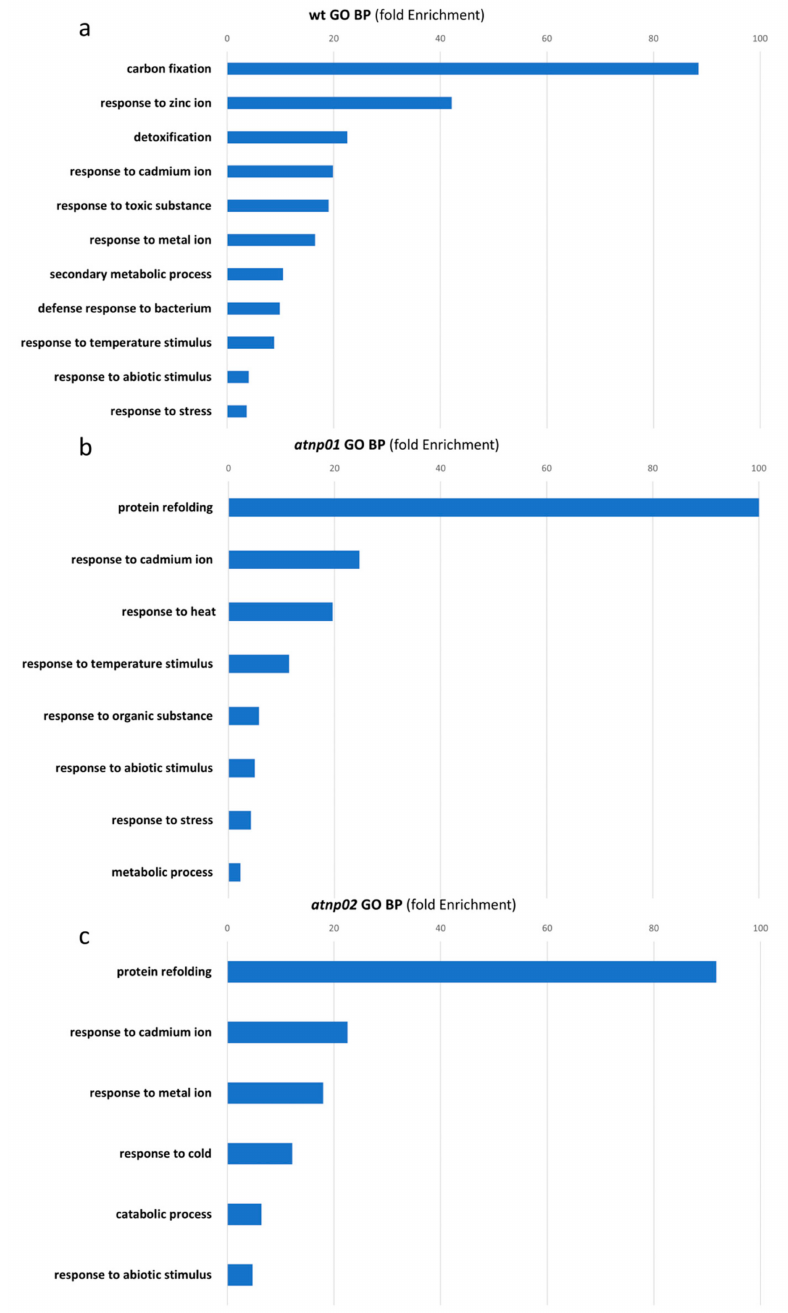
Figure 4. Gene ontology and analyses with n-fold enrichment = − log10 (Fisher’s exact p -value) for Biological process in wt ( a ), atnp 01 ( b ) and atnp 02 ( c